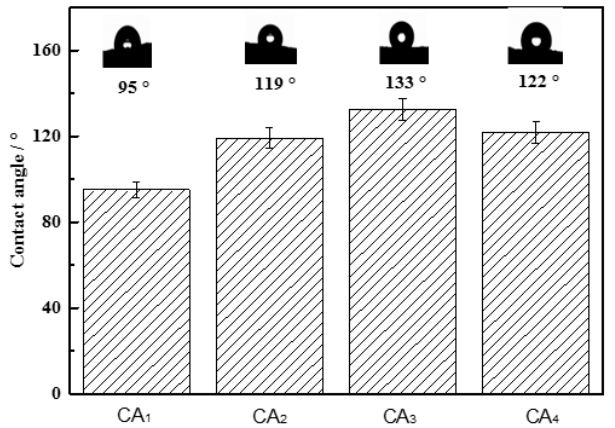
Figure 5. Water contact angle of carbon aerogels. The error bar in each column indicates the standard deviation.